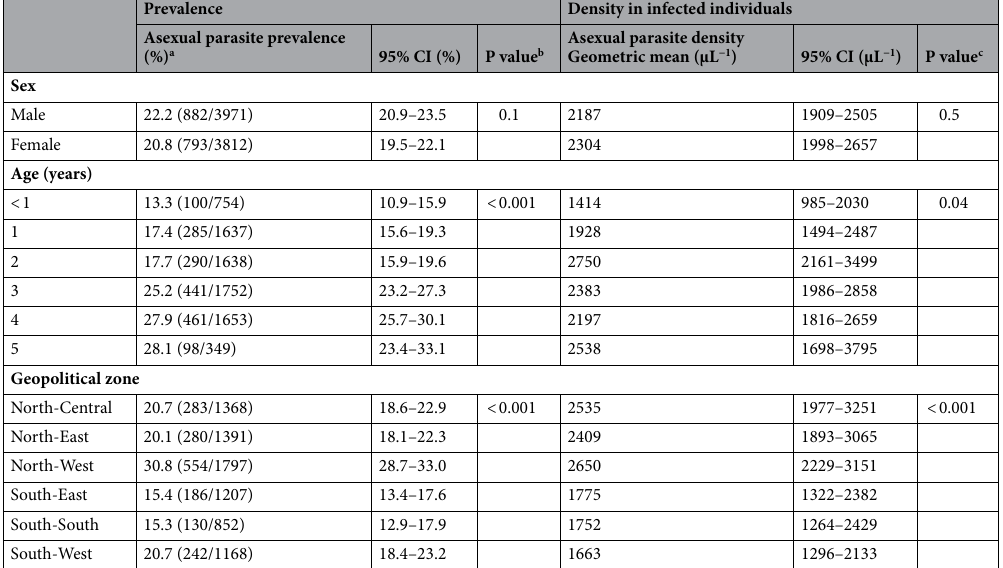
Table 1. Asexual malaria parasite prevalence and density according to sex, age and geopolitical zone in 7783 children up to 5 years of age with complete microscopy data for all variables. a Note that the prevalence numbers have slightly different denominators from those in the original published report on the DHS prevalence data 14 , as only slides with complete data for all variables including parasite density are analysed here. b Pearson’s chi squared test. c Mann–Whitney or Kruskal–Wallis tests.